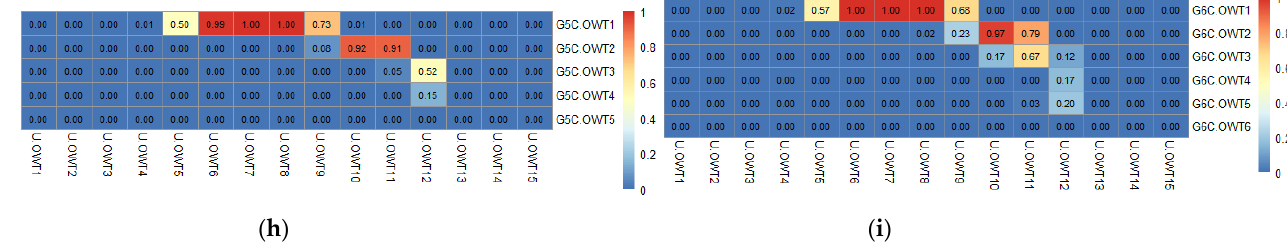
Figure 4. The U-OWT memberships of each water class (represented by mean nR rs ( λ ) vector) corresponding to different AOP-based OWT schemes: (a) JL68 (B = 0.1), ( b ) MO09, ( c ) WE16, ( d ) JK17, ( e ) PT19, ( f ) CST, ( g ) MO14, ( h ) G5C, and ( i ) G6C. The relationships of the U-OWT with JL68 (B = 0.01) and with JL68 (B = 0.001) are not shown here, because of their high similarity to the JL68 (B = 0.1).